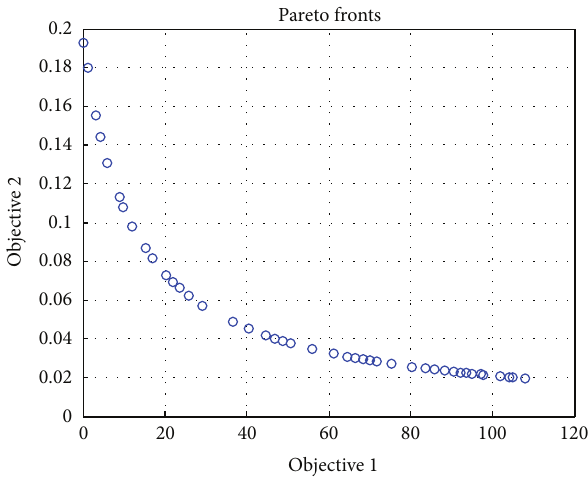
Figure 6: Evaluation of the effect of raising prices by adjusting the price raising factor 𝛿 .